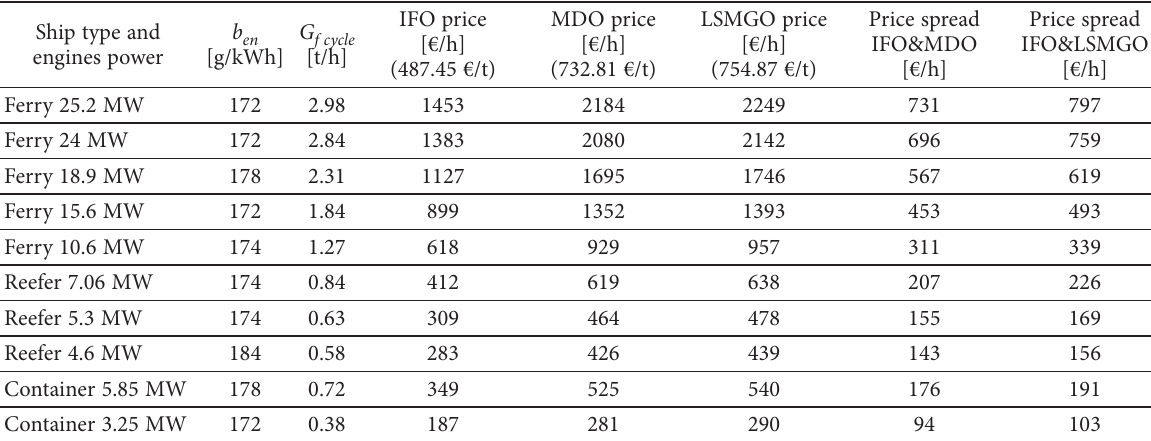
Table 6. Price spread between IFO, MDO and LSMGO per motor hour Ship type and engines power